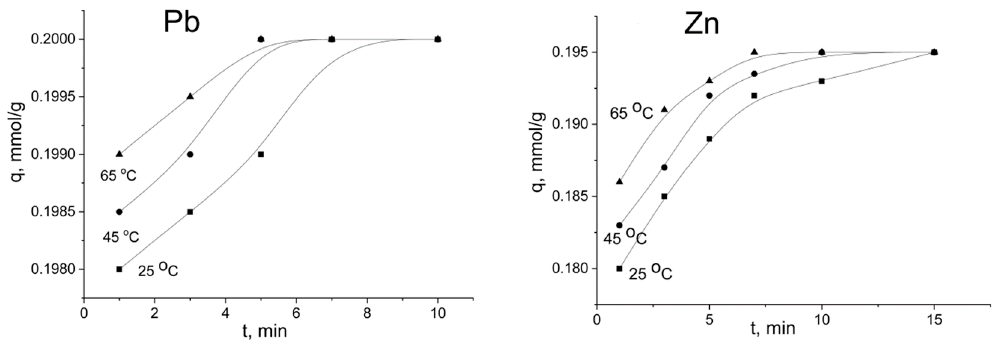
Figure 7. Sorption kinetics of lead and zinc ions at 25–65 ◦ C on titanium phosphate. The initial concentration of Pb 2 + and Zn 2 + ions was 1 mmol · L − 1 .